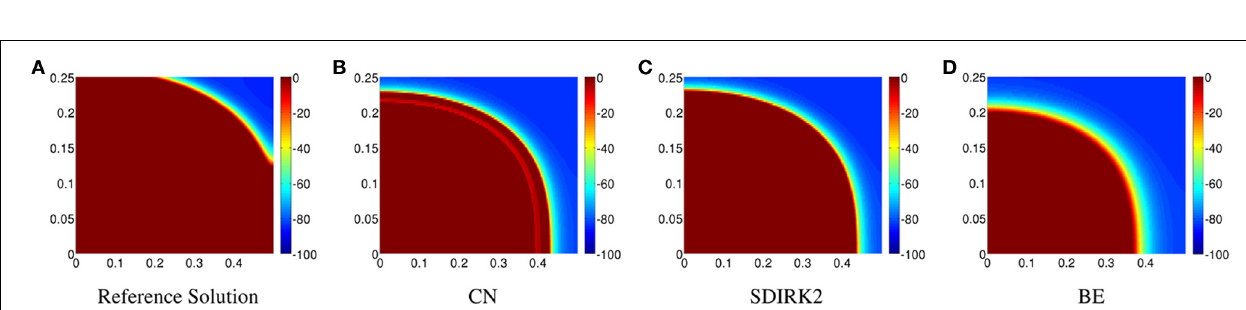
FIGURE 1 | Plots of the transmembrane potential at the spatial point (0.125, 0.125) and t ∈ [0, 20]ms for Scenario I: (A) reference solution, (B) CN solution, (C) SDIRK2 solution, and (D) BE solution.